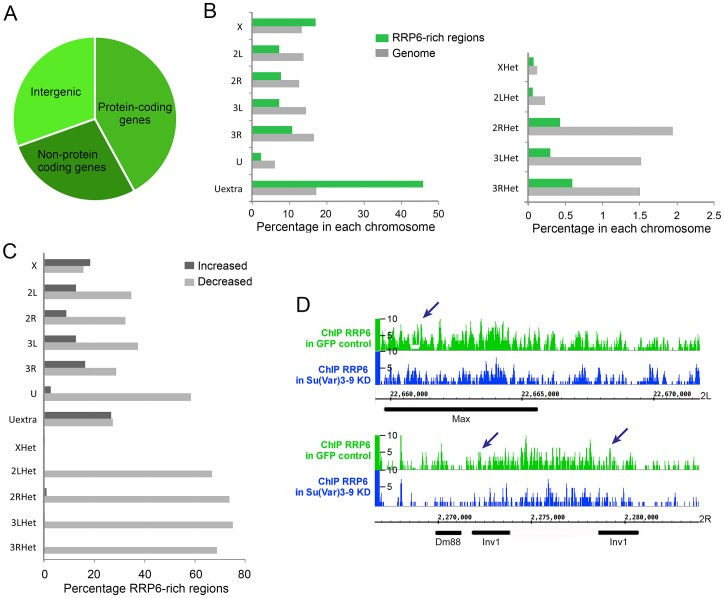
Depletion of SU(VAR)3-9 influences RRP6 genomic occupancy in S2 cells.ChIP-seq experiments were carried out using S2 cells that expressed V5-tagged RRP6 under low-induction conditions. Chromatin preparations from control GFP cells and from cells depleted of SU(VAR)3-9 were used for ChIP-seq using an anti-V5 antibody. (A) Pie diagram showing the association of RRP6-rich regions with different types of sequences in control cells. (B) Chromosome distribution of RRP6 expressed in control cells as percentage of RRP6-rich regions in each chromosome (green bars). Two different scales are shown due to the lower fraction of regions in the heterochromatic scaffolds compared to the rest of the chromosome arms. The grey bars indicate the fraction of the genome corresponding to each chromosome, for comparison. (C) Depletion of SU-VAR)3-9 affects RRP6 genomic occupancy. For each chromosome or scaffold, the number of RRP6-rich regions upregulated or downregulated is expressed as percentage of the number of changed regions relative to the number of regions in that same chromosome in control cells. The percentage of affected regions is much higher in heterochromatin. (D) RRP6 occupancy in the genomic regions analyzed in Fig 4. The arrows indicate the regions amplified in the qPCR assays.